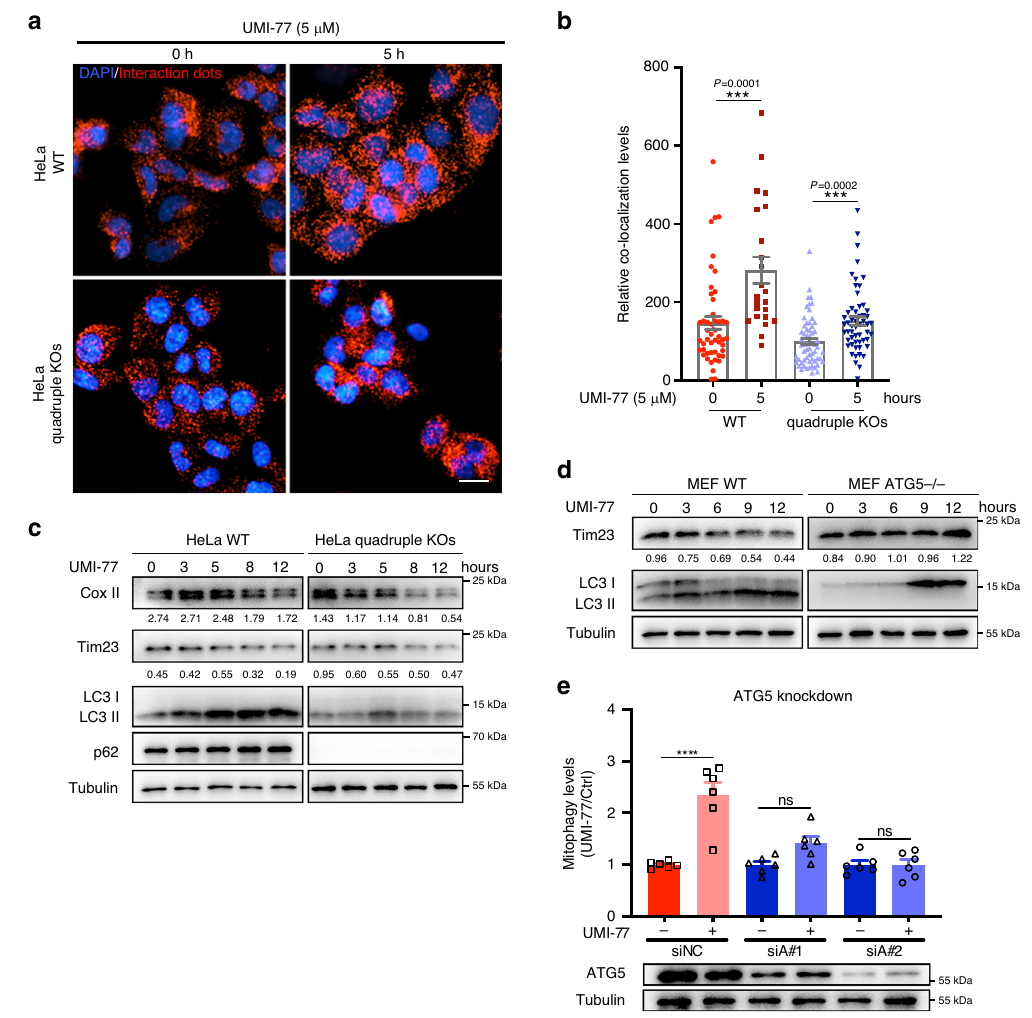
Fig. 4 UMI-77 induces mitophagy in an ATG5-dependent manner, independent of adapter proteins NBR1, TAX1BP1, p62, and NDP52. a PLA assay for MCL-1 and LC3A were performed in HeLa WT and quadruple KOs (NBR1, TAX1BP1, p62, and NDP52 knockout) cells treated with UMI-77 (5 µ M) for the indicated times. Cells were analyzed by fl uorescence microscopy. Scale bar, 20 μ m. b Quanti fi cation of the mean area dots from a by two-tailed t test (data represents mean ± S.E.M. The sample size was, in turn, n = 49, n = 23, n = 60, n = 55 cells, *** p < 0.001). c HeLa WT and quadruple KOs (NBR1, TAX1BP1, p62, and NDP52 knockout) cells were treated with 5 µ M UMI-77 for the indicated times and cell lysates were immunoblotted with indicated antibodies. The numbers under the blots represent the gray scale quanti fi cation (Cox II/Tubulin, Tim23/Tubulin). d MEF WT and ATG5 knockout cells were treated with 5 µ M UMI-77 for the indicated times, and mitochondrial marker protein Tim23 and LC3 were detected by western blotting. The numbers under the blots represent the gray scale quanti fi cation (Tim23/Tubulin). e The mitophagy levels of control cells and ATG5 knockdown cells treated with UMI-77 were analyzed using one-way ANOVA (data represent mean ± S.E.M.; n = 6. **** p < 0.0001. ns, not signi fi cant). The siRNA knockdown ef fi ciency was shown using western blot. siNC: scrambled siRNA. Source data are provided as a Source Data fi